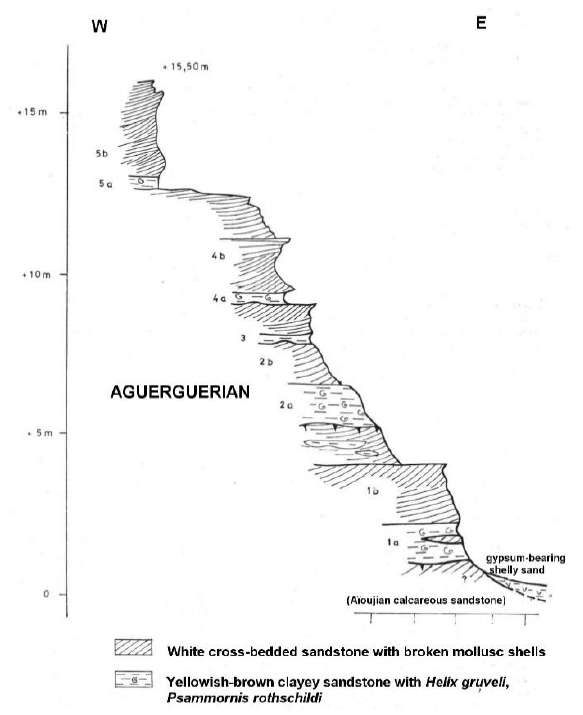
Figure 5. Section showing Aguerguerian deposits at ‘point kilométrique 52′ at the north-eastern end of Lévrier Bay, north-western Mauritania. White cross-bedded sandstones alternate with yellowish- brown clayey sandstones containing the snail Helix gruveli and in situ Psammornis eggshells. The main Psammornis- bearing horizon is at the bottom of the section. Modified after Hébrard [56]. Although the Aguerguerian has long been considered as Middle Pleistocene, its exact age remained uncertain until radiometric dates became available. C14 ages of more than 39,900 years were obtained for Psammornis eggshell fragments [55], but this was a